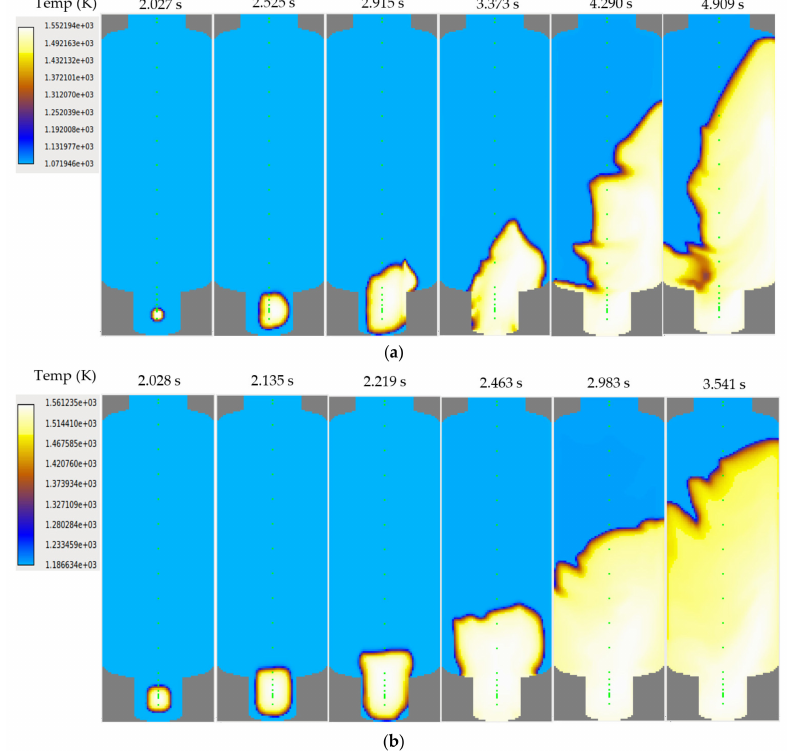
Figure 6. Temperature contours on the center plane for the Test HD-15 by COM3D. ( a ) Calculation by the Bradley model; and ( b ) Calculation by the Kawanabe